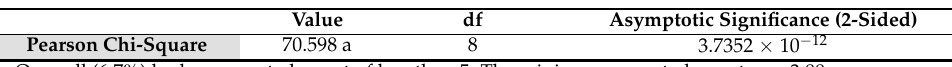
Table 7. Chi-square